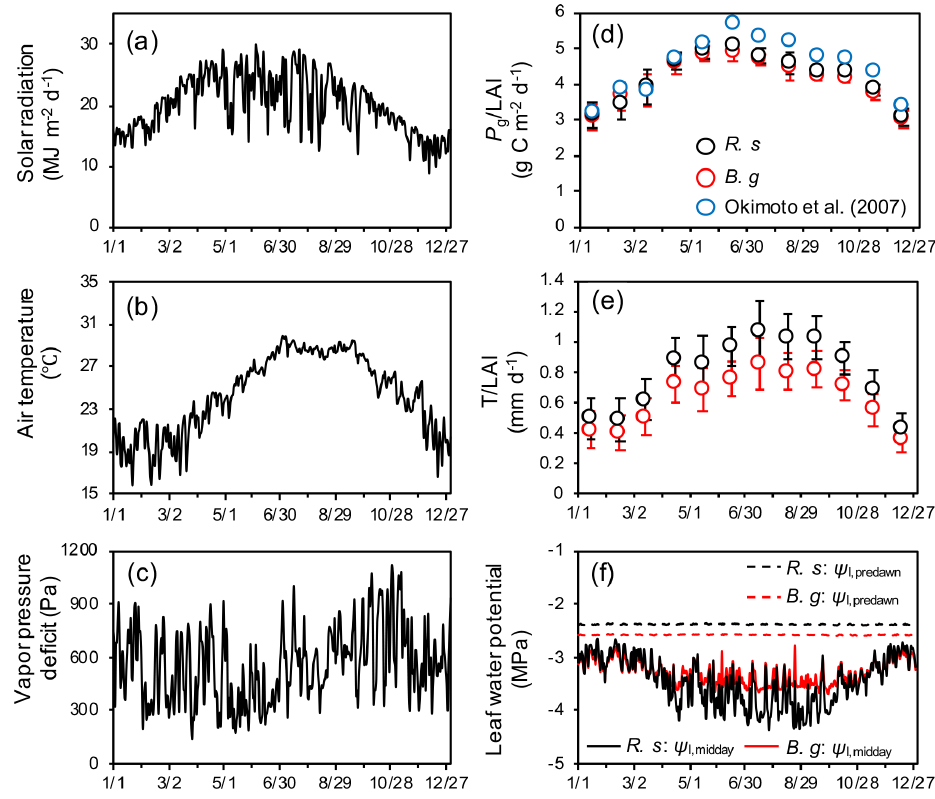
Figure 4. Seasonal variations in atmospheric forcing variables: (a) solar radiation, (b) air temperature, and (c) vapor pressure deficit (VPD). Modeled seasonal dynamics: (d) monthly mean and standard deviation of species-specific gross photosynthetic rate ( P g , gC per square meter ground per day), (e) transpiration ( T , mmd − 1 ) normalized by leaf layer index (LAI, m 2 m − 2 ) of the respective species, and (f) midday ( (cid:57) l , midday ) and predawn ( (cid:57) l , predawn ) leaf water potential of each species. R. s : R. stylosa ; B. g : B. gymnorrhiza . Solar radiation is expressed as daily sum, while air temperature and VPD are expressed as daily mean. The leaf water potential shown is the median value of individuals. Here, the modeled dynamics are from a simulation of soil salinity set as 30‰, and the results of a year when LAI reached 1.55 are shown. At this time, the LAIs of R. stylosa and B. gymnorrhiza are 0.87 and 0.68, respectively. In panel (d) , seasonal variations in P g / LAI measured by Okiomoto et al. (2007) are also shown as reference, the data of which are from an area with LAI = 1.55 in the Fukido mangrove forest in